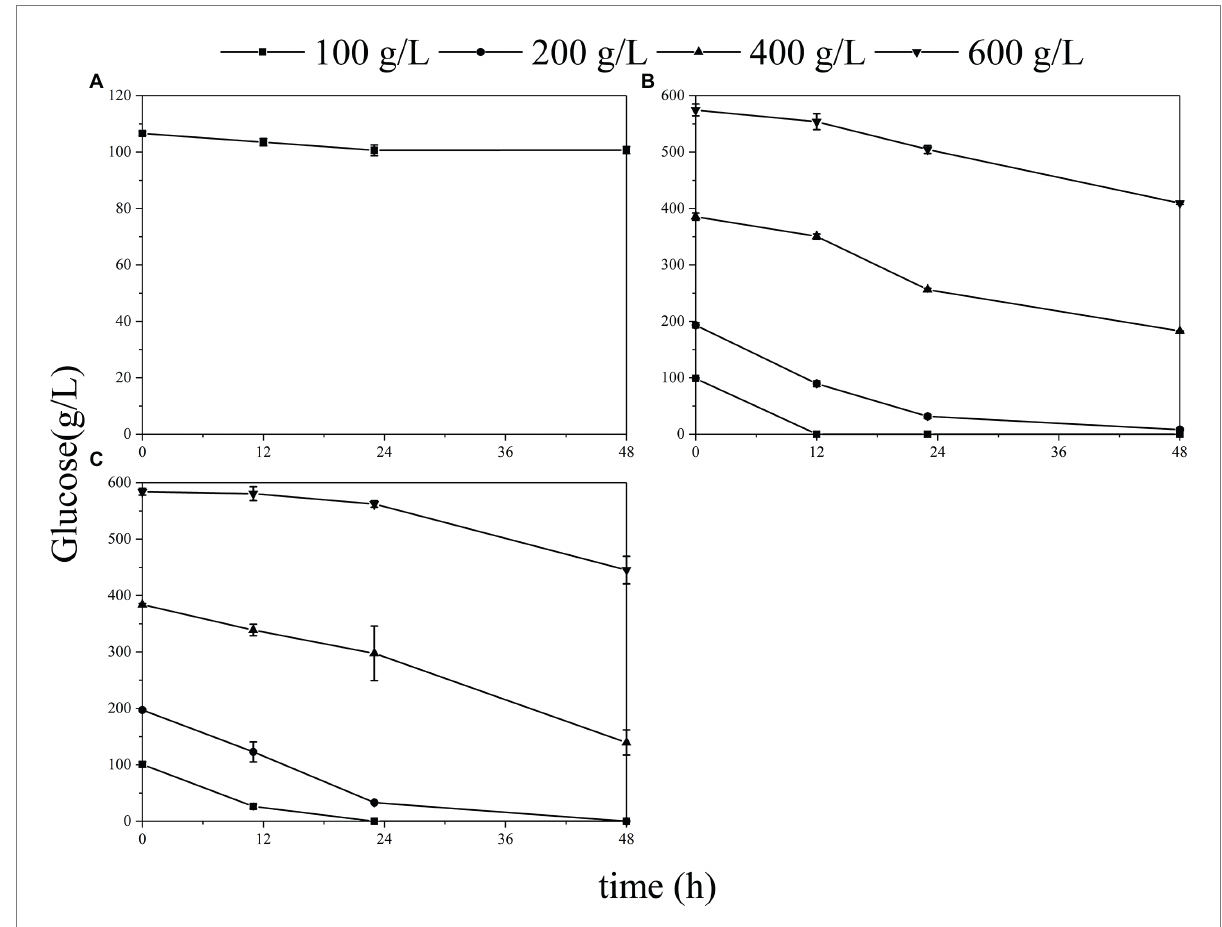
FIGURE 2 Glucose consumption of the E. coli (A) , S. cerevisiae (B), and G. oxydans (C) at different glucose